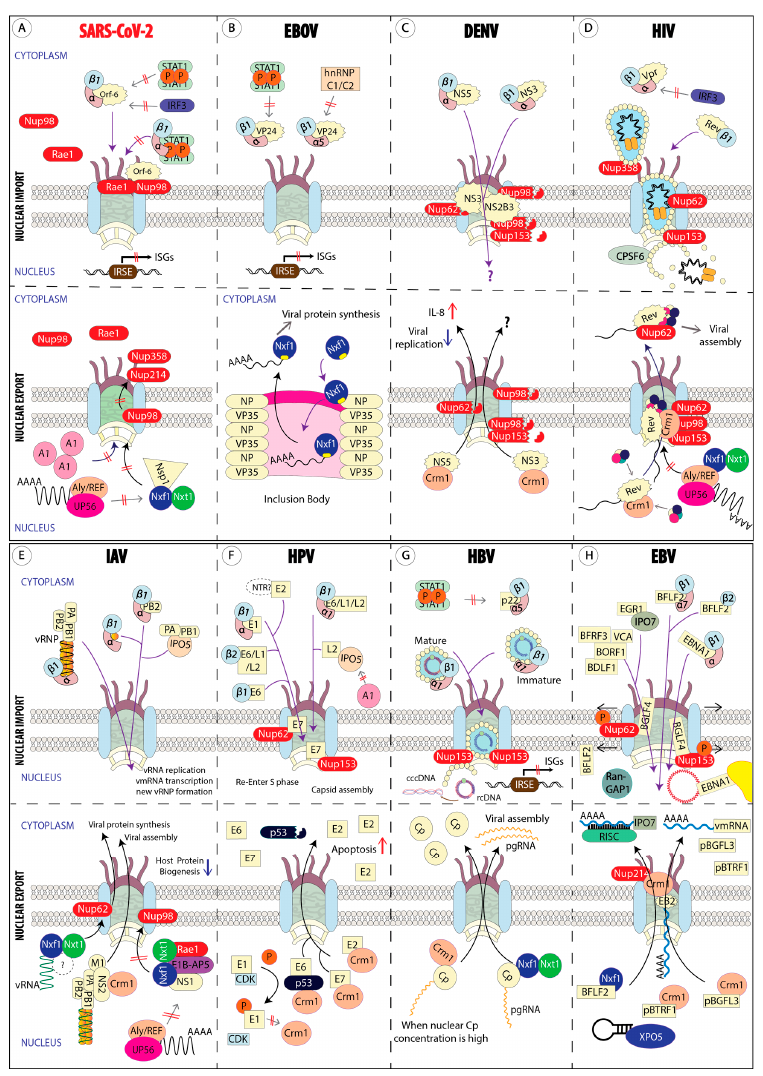
Figure 1. Interaction between viral factors and host factors to hijack host nuclear transport machinery. ( A )